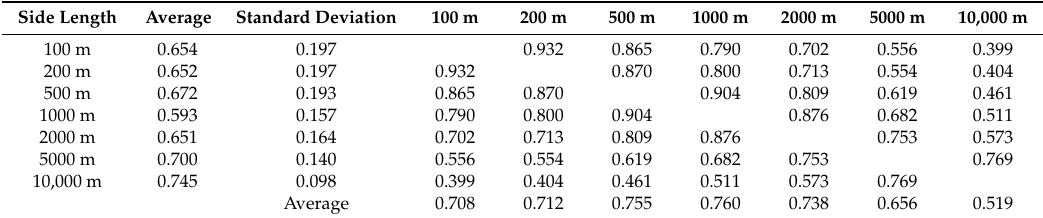
Table 9. Correlation matrix and basic statistic parameters for 1000 randomly selected control